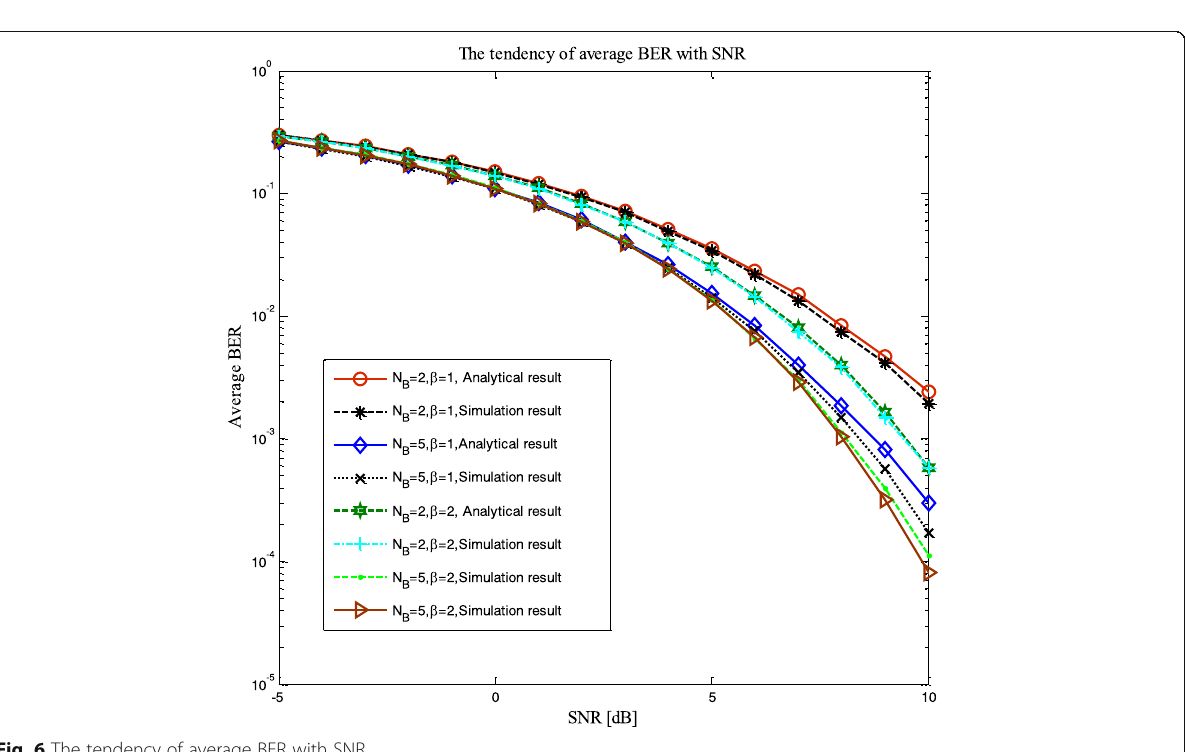
Fig. 6 The tendency of average BER with